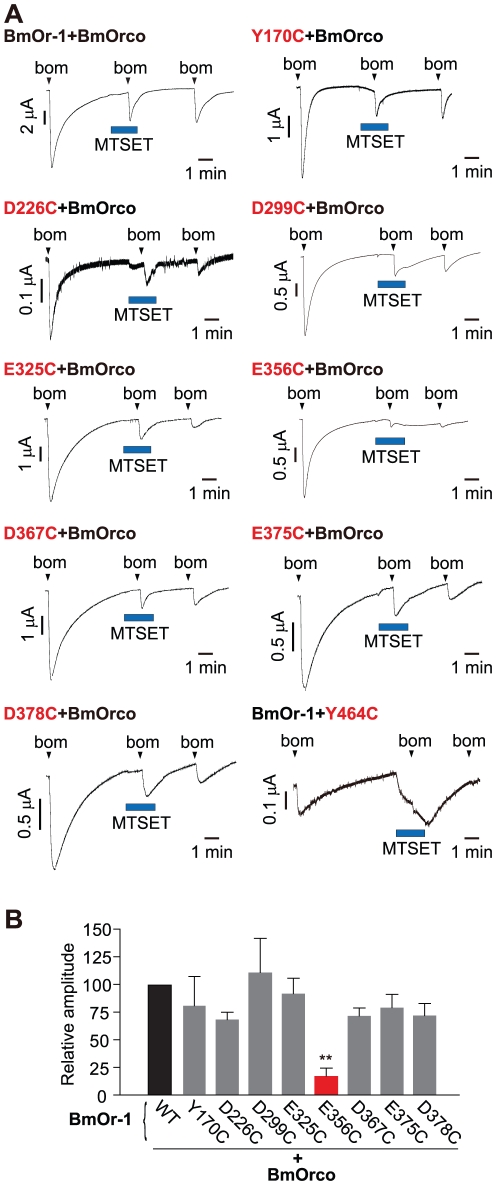
Effect of MTSET on ionic permeability of WT and Cys mutant BmOr-1-BmOrco complexes.(A) Representative current traces of oocytes expressing WT or mutant BmOr-1 or BmOrco. Bombykol (1 µM) and MTSET (2.5 mM) were applied at the time indicated by arrowheads and blue squares, respectively. (B) Summary of effects of MTSET on the bombykol response of WT (black bar) and mutant BmOr-1 (gray bars). The mutant with a significant effect on ion permeability is colored in red (unpaired Student's t-test, mutant vs. WT **p<0.01). Data are shown as mean ± S.E.M., n = 5 (see also Figure S4).